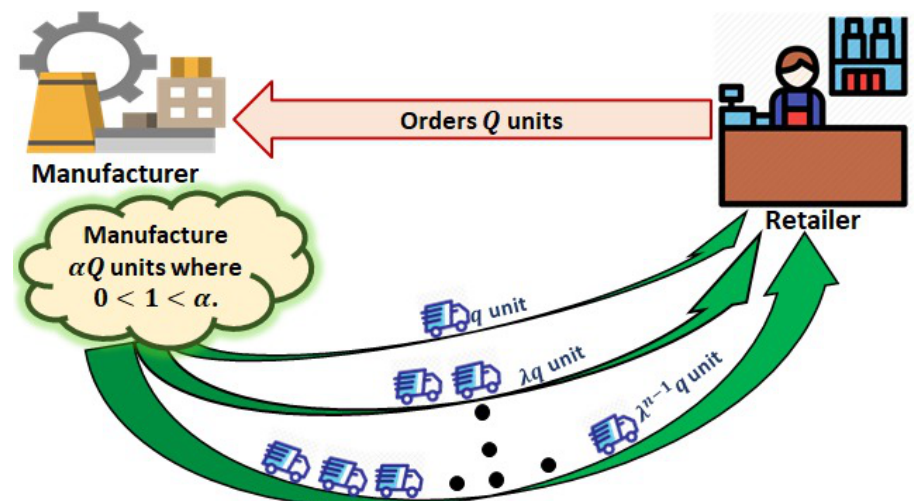
Figure 1. Single-setup-multi-unequal-increasing-delivery (SSMUID)